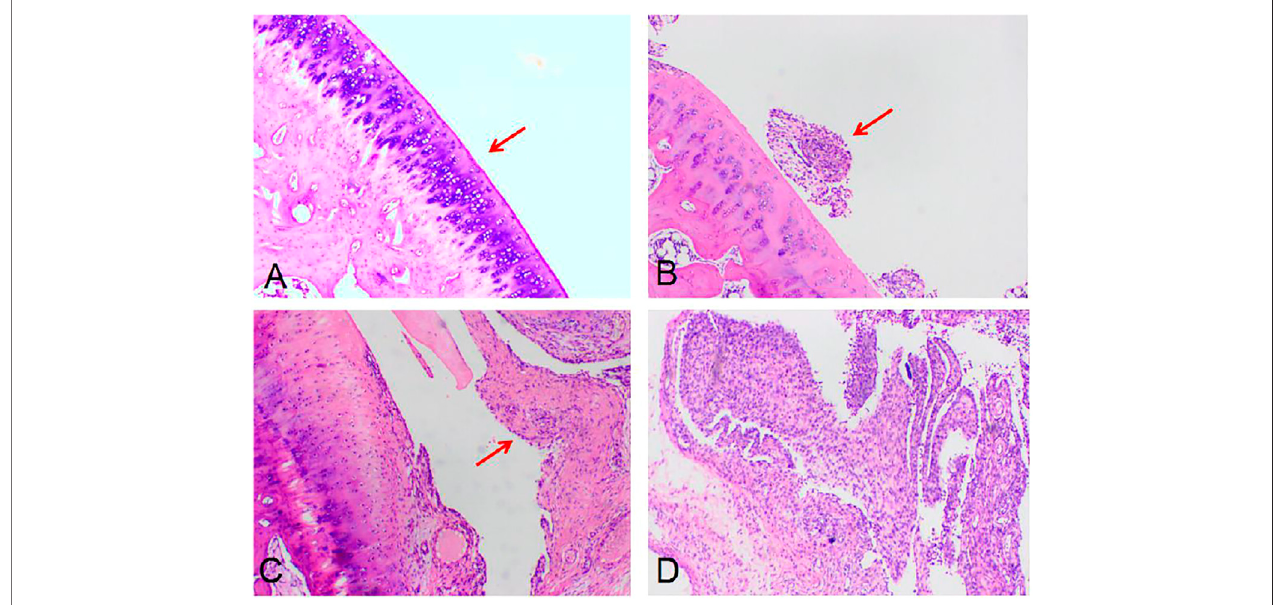
FIGURE 8 | Pathological results of synovitis. The surface of bone and joint is smooth without synovium hyperplasia (TP-SLN and BS group, (A) ). Mild synovial hyperplasia, a small number of in fl ammatory cells and synovial cells increased (TP group, (B) ). Severe synovial hyperplasia with a large number of in fl ammatory cell in fi ltration and ulceration of lining layer (DMSO and control group, (C) and (D) ) (red arrow, HE, 40×).